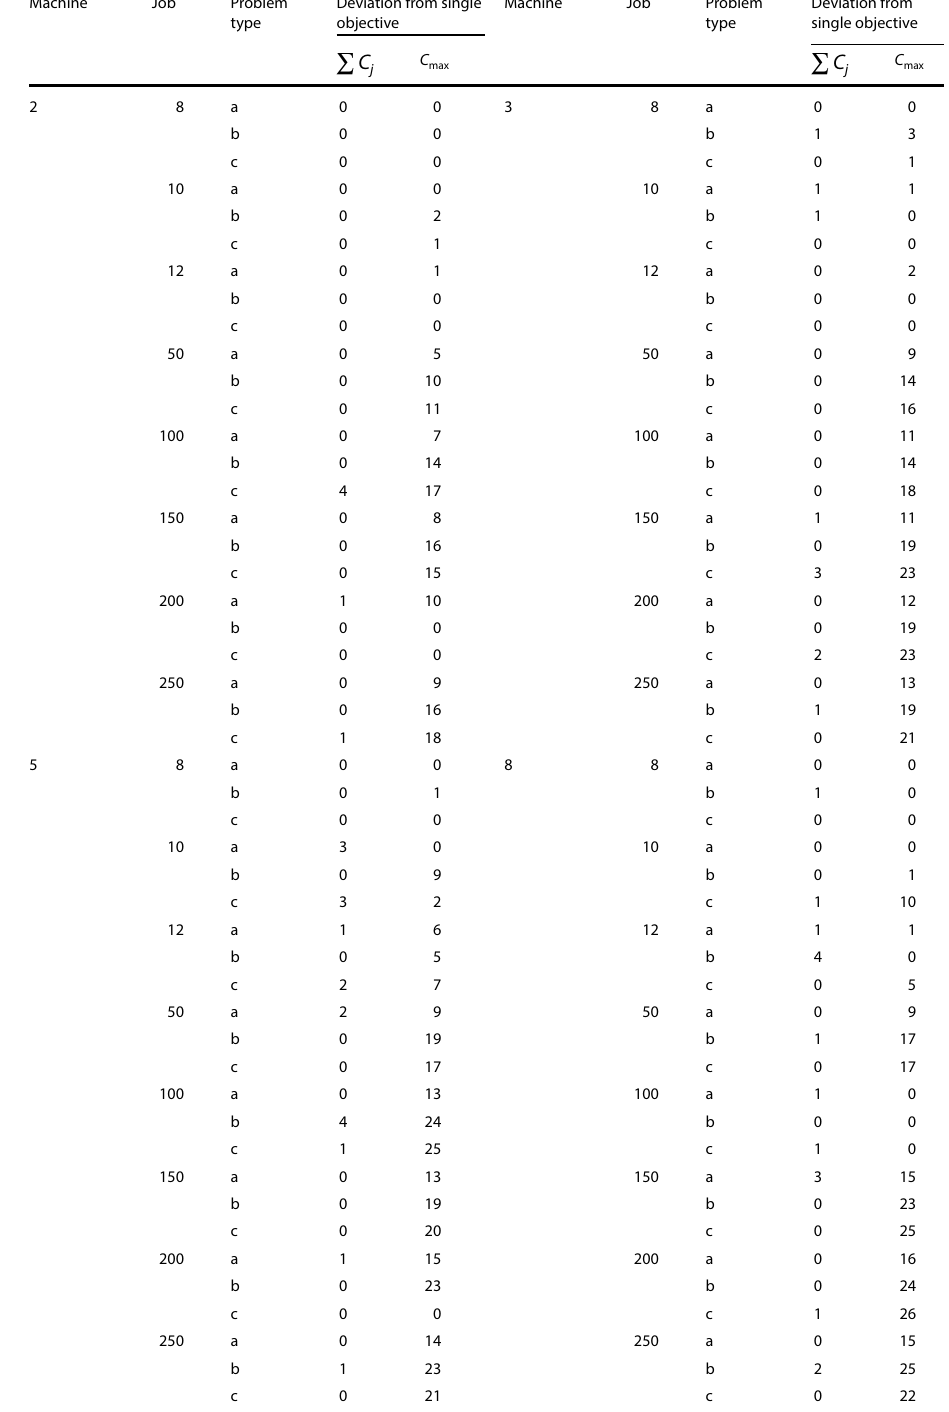
Table 6 Computational results of HGLGSA in case of satisfaction